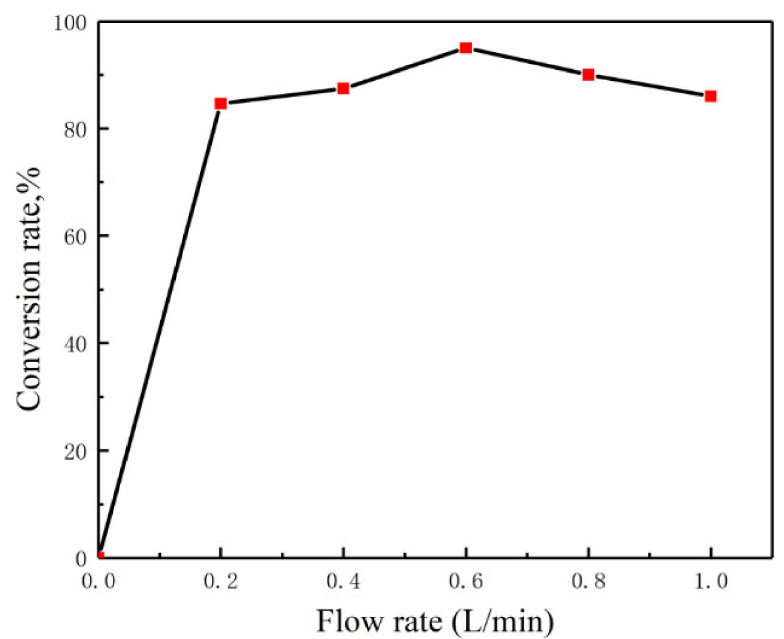
Figure 4. Effect of flow rate on the digestion of ammonium chloride.